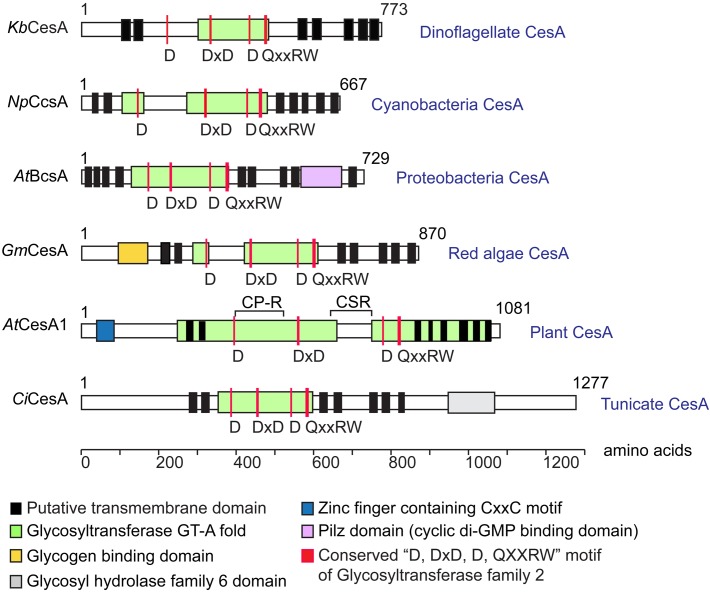
Predicted domains arrangement of selected CesA orthologs. Domain organizations of CesAs of Karenia brevis (KbCesA, KY352307), Nostoc punctiforme (NpCcsA, YP_001865112.1), Agrobacterium tumefaciens (AtBcsA, NP_357298.1), Griffithsia monilis (GmCesA, ADK77974.1), Arabidopsis thaliana (AtCesA1, AEE86053.1), and Ciona intestinalis (CiCesA, NP_001041448.1) are given for comparison. Dinoflagellate KbCesA contained the conserved CesA catalytic motif (D, DxD, D, and QxxRW), amid low levels of overall sequence similarity with other CesA orthologs at the catalytic domain (e.g., ∼20–25% with CesAps from Arabidopsis; 83% between KbCesAp and the LpCesA1p). Dinoflagellate CesAs encode predicted polypeptides (∼90 kDa) similar in size to bacterial CesA (BcsA), but much smaller than other eukaryotic CesAps.